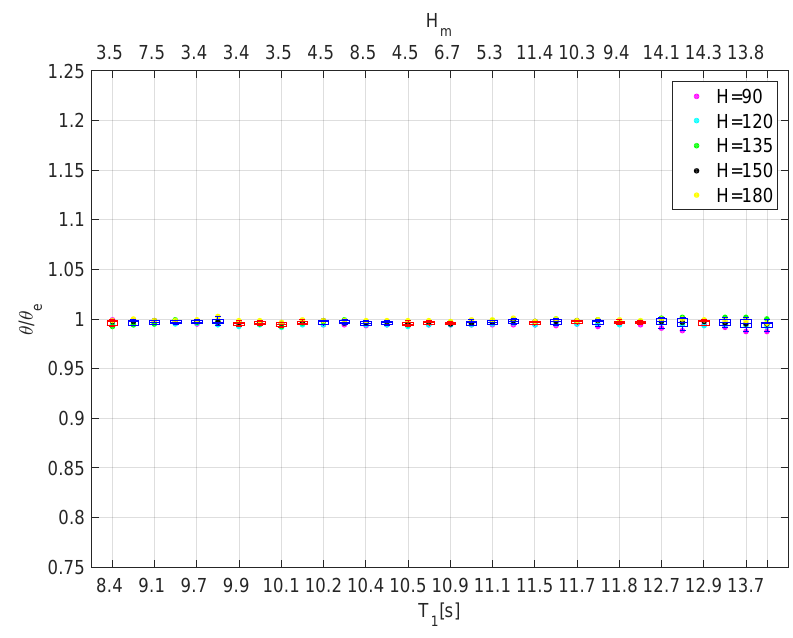
Figure 6. Box-plot showing the ratio between the estimated and measured mean wave direction, obtained by means of the conventional approach.